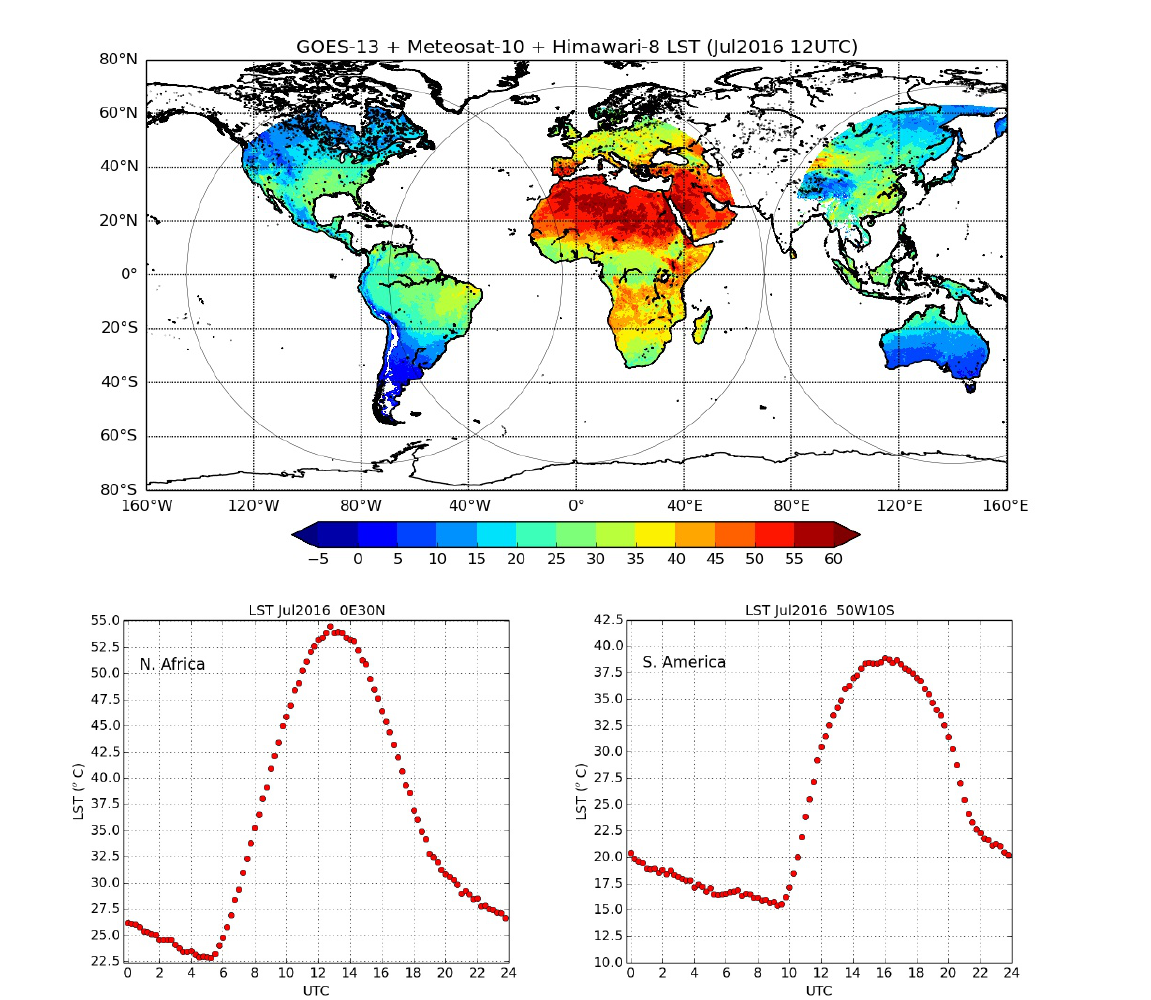
Figure 3. Median Land Surface Temperature (LST, ◦ C) for all 12 UTC LST estimates in July 2016, derived from GOES-13, MSG/SEVIRI and Himawari-8 observations (upper panel; the circles mark the respective 70 o disks). The median LST diurnal cycle for July 2016 is shown in the lower panels, for two pixels (desert landscape in Northern Africa, lower-left, and Savannah in South America,